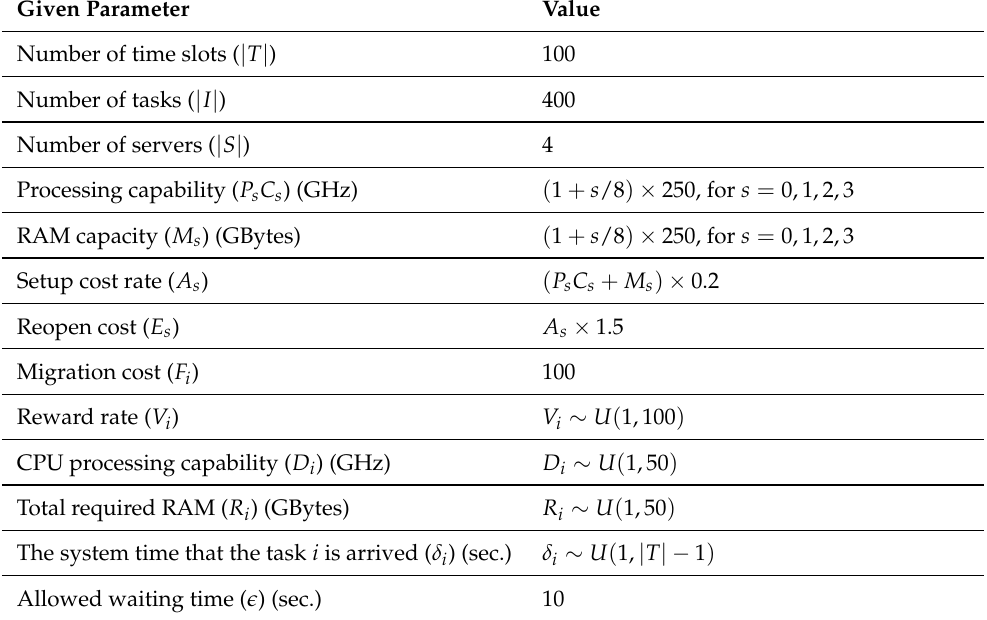
Table 4. Parameters for computational